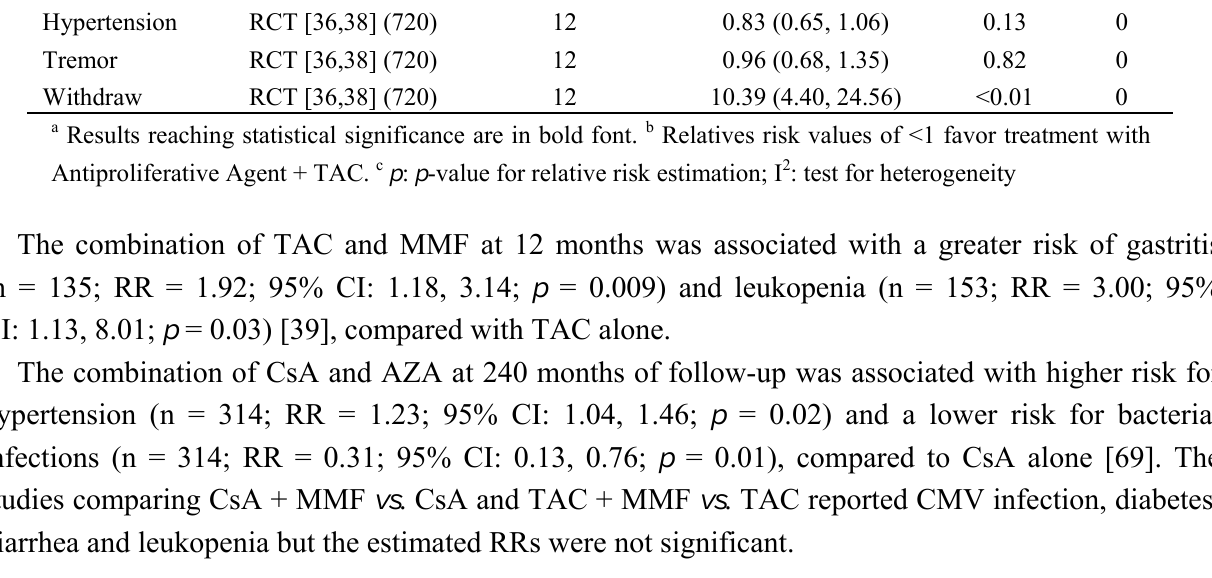
Table 5. Meta-analysis results of outcomes reported by studies comparing TAC + AZA vs. TAC a . Statistics c Relative Risk b Outcome Study Design (N) Time in months (95% CI) p I 2 Total Infections RCT [36,38] (720) 12 0.99 (0.82, 1.20) 0.94 0 Leukopenia RCT [36,38] (720) 12 8.41 (3.36, 21.02) <0.01 0 Diabetes mellitus RCT [36,38] (720) 12 0.85 (0.41, 1.76) 0.67 0 Hypertension RCT [36,38] (720) 12 0.83 (0.65, 1.06) 0.13 0 Tremor RCT [36,38] (720) 12 0.96 (0.68, 1.35) 0.82 0 Withdraw RCT [36,38] (720) 12 10.39 (4.40, 24.56) <0.01 0 a Results reaching statistical significance are in bold font. b Relatives risk values of <1 favor treatment